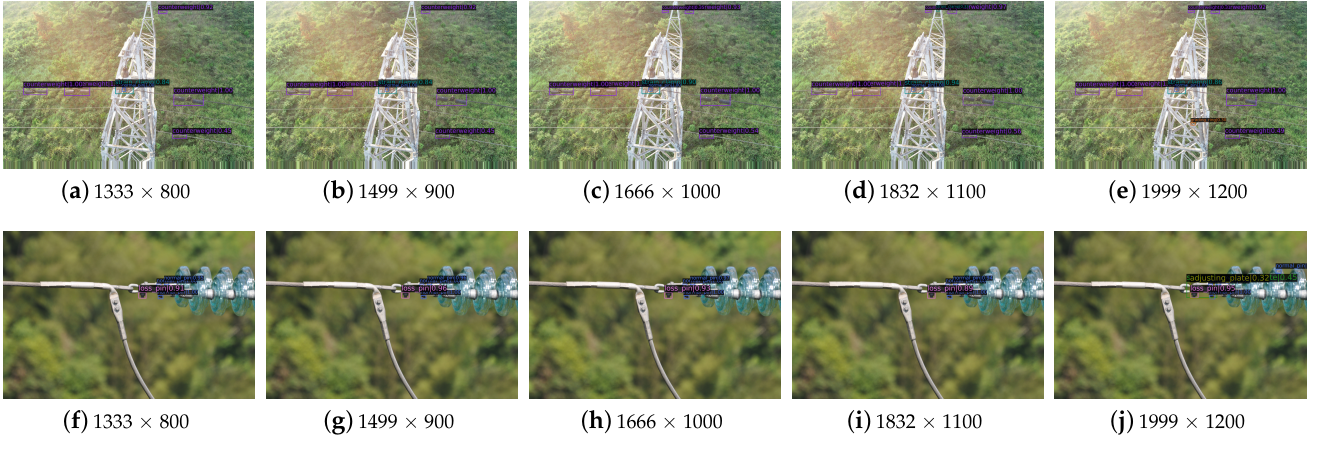
Figure 9. Visual results of detection of objects with different image